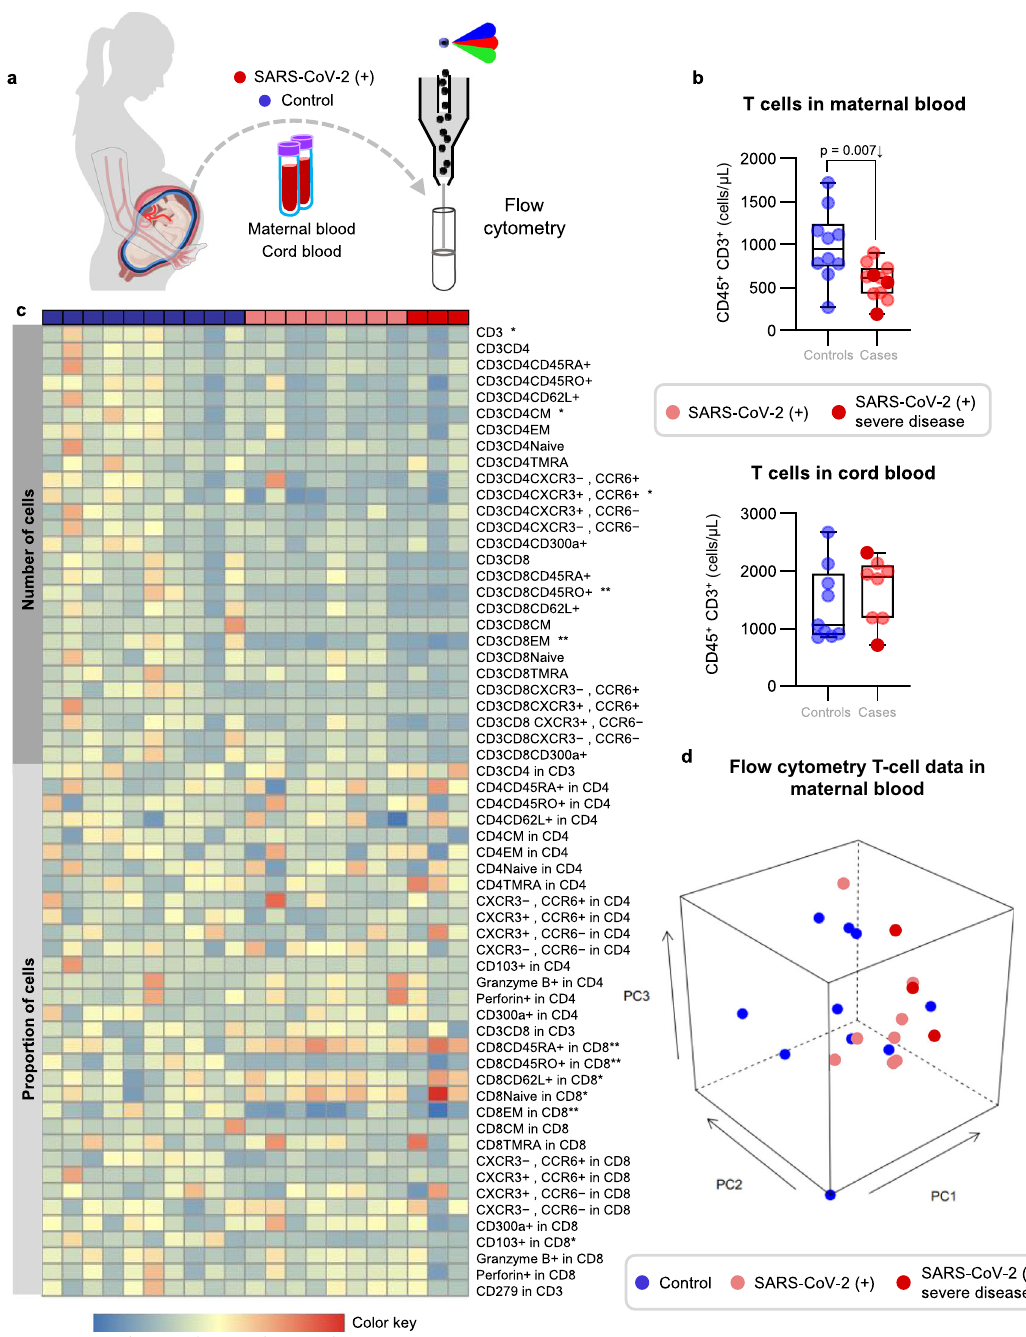
Fig. 2 Immunophenotyping of T cells in the maternal and cord blood of women with SARS-CoV-2 infection and their neonates. a Maternal blood and cord blood were collected for immunophenotyping. b Numbers of T cells in the peripheral blood [ n = 10 control, 11 SARS-CoV-2 ( + )] and cord blood [ n = 9 control, 8 SARS-CoV-2 ( + )]. Data are shown as boxplots where midlines indicate medians, boxes indicate interquartile range and whiskers indicate minimum/maximum range. Differences between groups were evaluated by Mann – Whitney U -tests. P values < 0.05 were used to denote a signi fi cant result. Blue dots indicate control women, light red dots indicate SARS-CoV-2 ( + ) women, and dark red dots indicate women with severe COVID-19. c Heatmap showing the abundance ( z -scores) of T-cell subsets in the maternal blood from SARS-CoV-2 ( + ) or control women [ n = 10 control, 11 SARS- CoV-2 ( + )], where cell numbers and proportions are shown. Differences between groups were assessed using two-sample t -tests. P values were adjusted for multiple comparisons using the false-discovery rate (FDR) method to obtain q values. * q < 0.1; ** q < 0.05. Red and blue indicate increased and decreased abundance, respectively. d Three-dimensional scatter plot showing the distribution of fl ow cytometry data. Blue dots indicate control women, light red dots indicate SARS-CoV-2 ( + ) women, and dark red dots indicate women with severe COVID-19 [ n = 10 control, 11 SARS-CoV-2( + )] based on principal component (PC)1 –